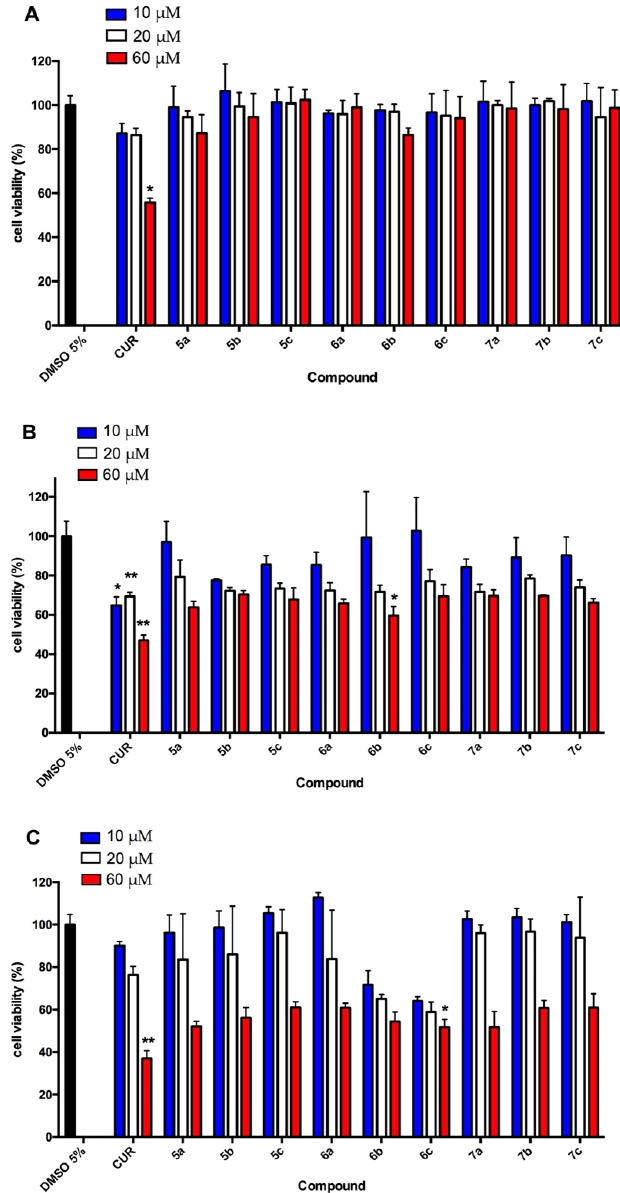
Figure 3. Effect of different concentrations of curcumin-analogs on the viability of two tumor cell lines: HT29 ( C ), MCF7 ( B ), and the non-tumoral NIH3T3 ( A ) cell line. Cells were incubated in the presence or not of the distinct compounds at three final concentrations (10, 20, and 60 µ M) for 24 h. Then, an MTT assay was used to evaluate the cell viability. Results are expressed as mean ± SD of three independent experiments. The statistical significance shown is with respect to the untreated controls (DMSO 0.5%). * p < 0.05; ** p <